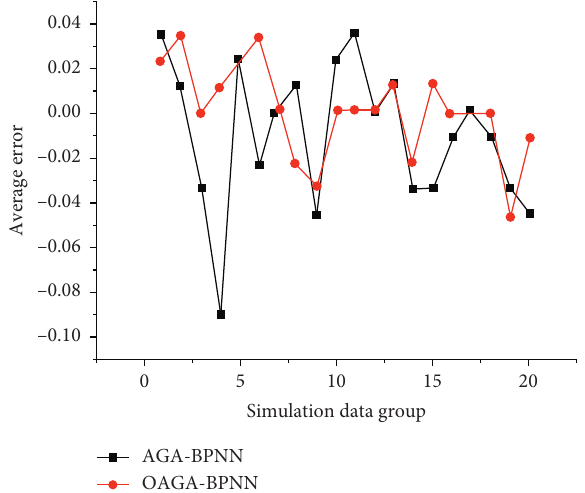
Figure 7: Comparison on average output error of the standard AGA-BPNN and